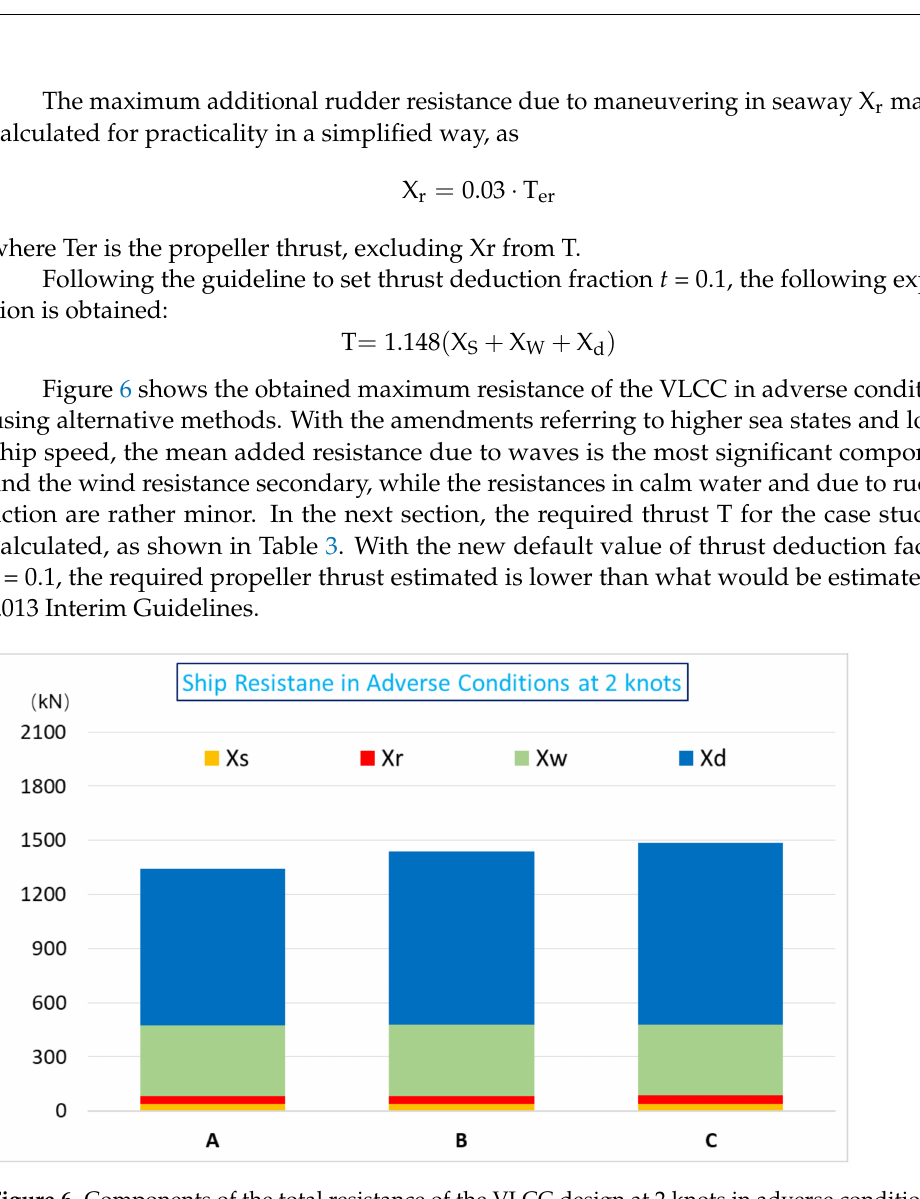
Figure 6. Components of the total resistance of the VLCC design at 2 knots in adverse conditions as defined by the IMO Guideline. Table 3. Resistance components and required propeller thrust